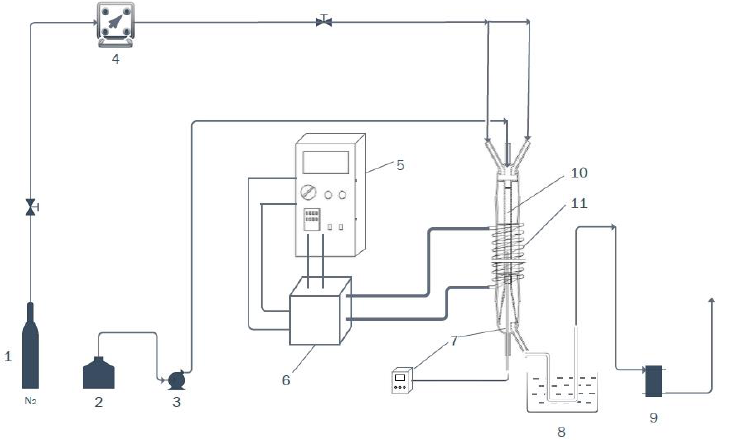
Figure 1. Schematic of electromagnetic induction high frequency high temperature cracking device. 1—Nitrogen; 2—feedstock; 3—feeding pump; 4—moisture mete; 5—High frequency induction heating power; 6—cooling system; 7—K type thermocouple; 8—Ice bath; 9—Gas- solid separator; 10—reactor; 11—Induction